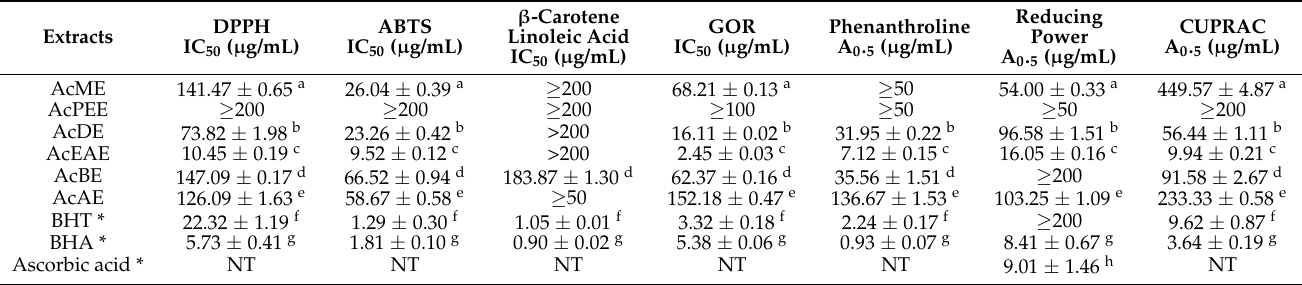
Table 5. Antioxidant potentials of different fractions of A. campestris